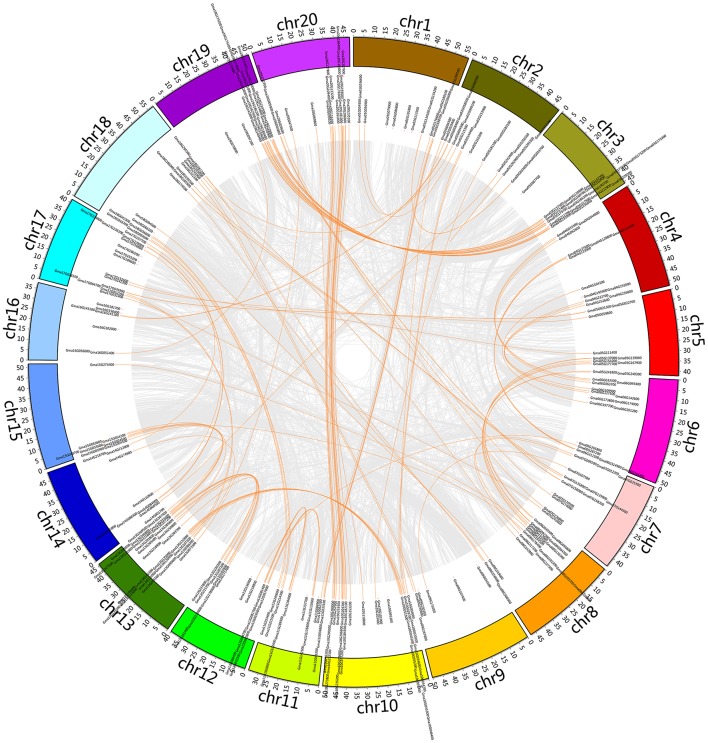
Chromosomal location of the soybean C2H2-ZF genes. The illustrated genome-wide chromosome organization caused by whole genome duplication events is accomplished using the Circos software based on the duplication coordinates defined in the soybean genome assembly v2.0. Segmental duplicated blocks are gray coded. Paralogous pairs of soybean C2H2-ZF genes are connected with orange lines.